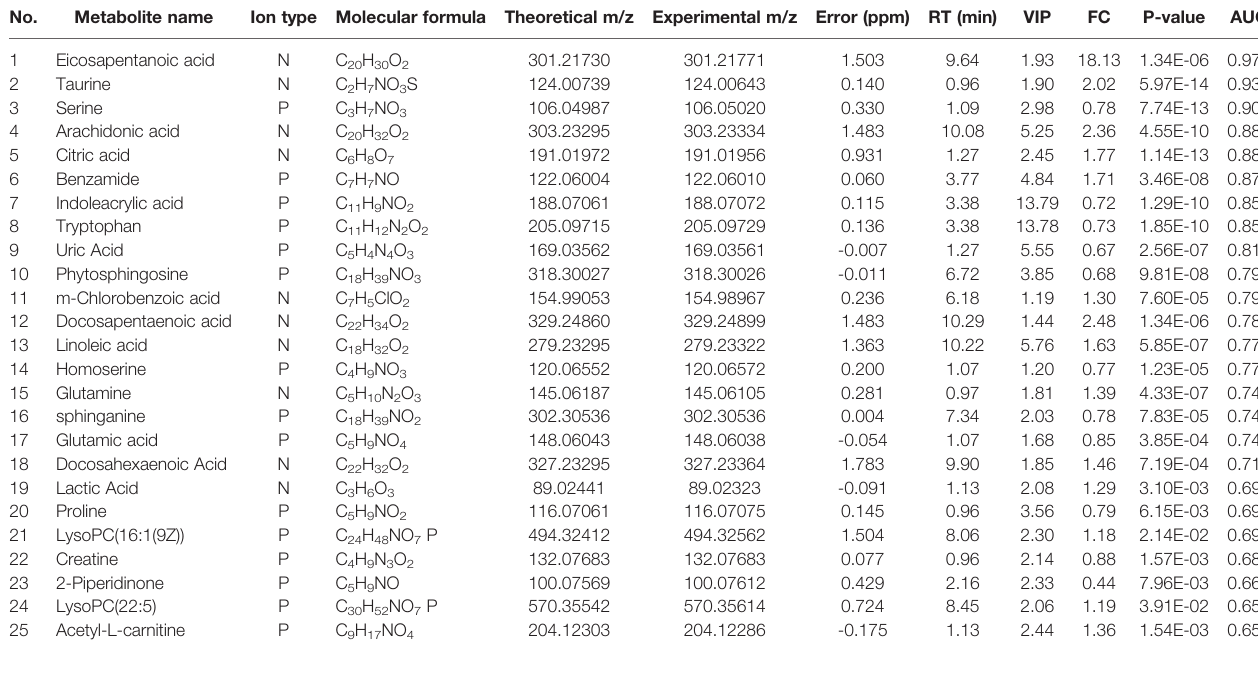
TABLE 3 | Differential metabolites between ROLP group and healthy